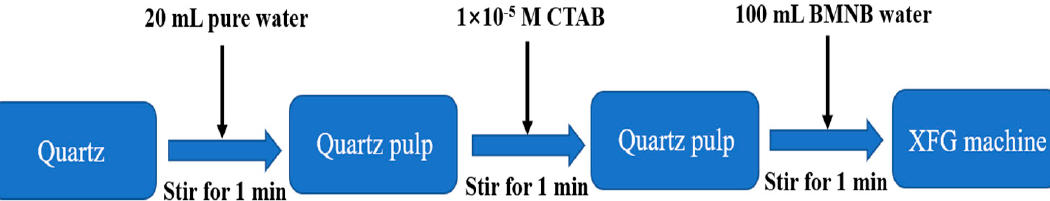
Figure 3. The step-wised experimental procedure.